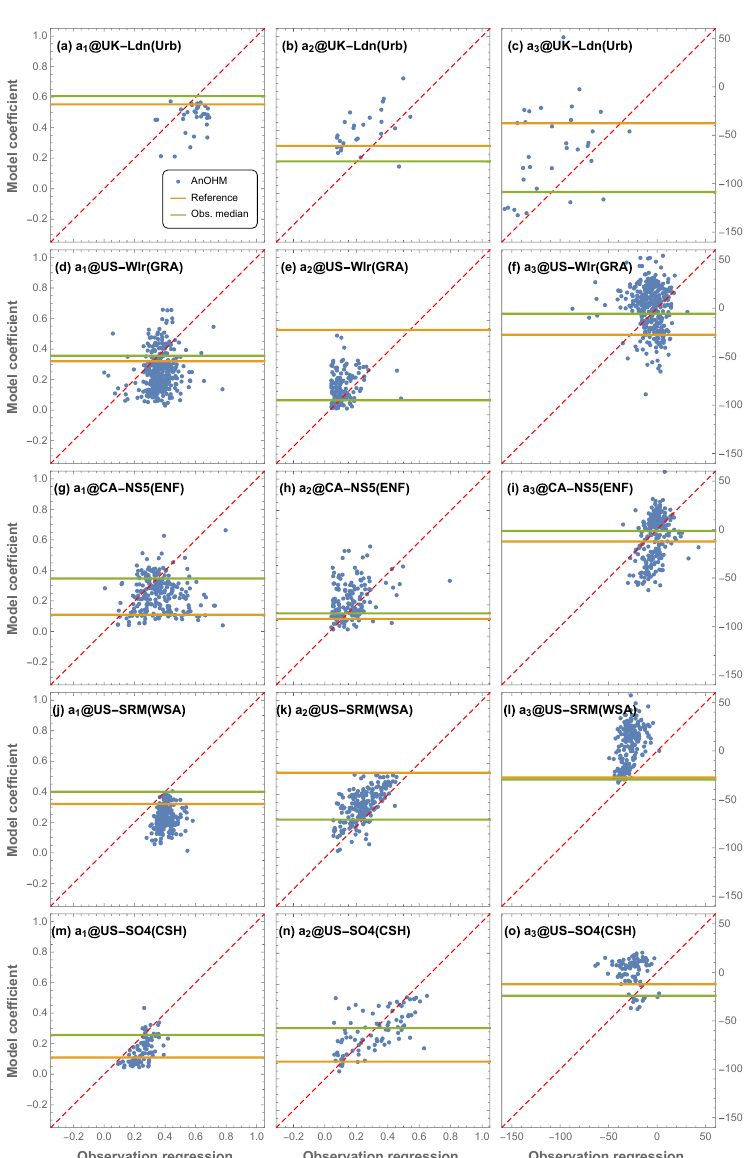
Figure B1. Comparison of OHM coefficients (left, central and right columns for a 1 , a 2 and a 3 , respectively) between different modelling approaches and observation regression at five sites: UK-Ldn (a, b, c) , US-Wlr (d, e, f) , CA-NS5 (g, h, i) , US-SRM (j, k, l) and US-SO4 (m, n, o) . The blue dots denote the paired values between AnOHM and observation regression. The orange lines represent the reference value used in OHM simulations for land covers of grass and tree (Grimmond and Oke, 1999), whereas the green lines show median values derived from results by observation regression at corresponding